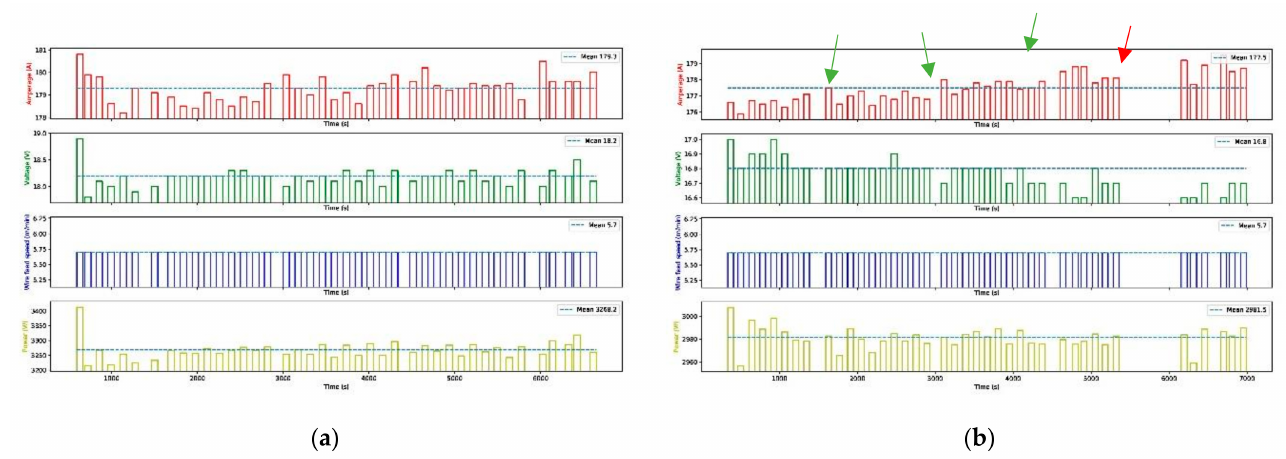
Figure 4. The AM parameters for the ternary blend ( a ) and binary blend ( b